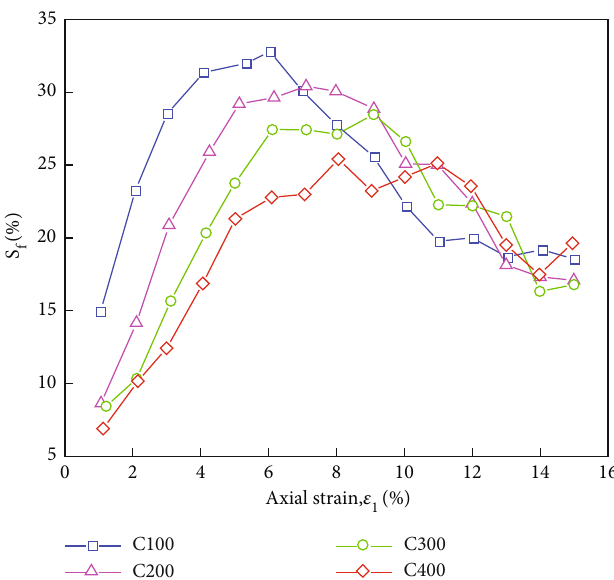
Figure 9: Evolution of sliding contact ratio considering particle breakage.